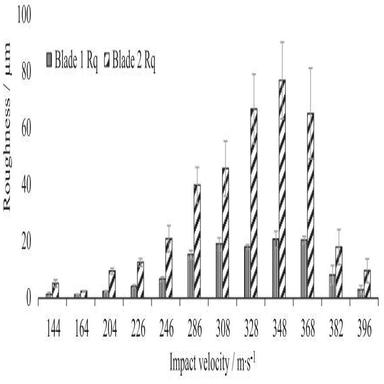
Comparison of Rq values between Blade 1 and Blade 2.